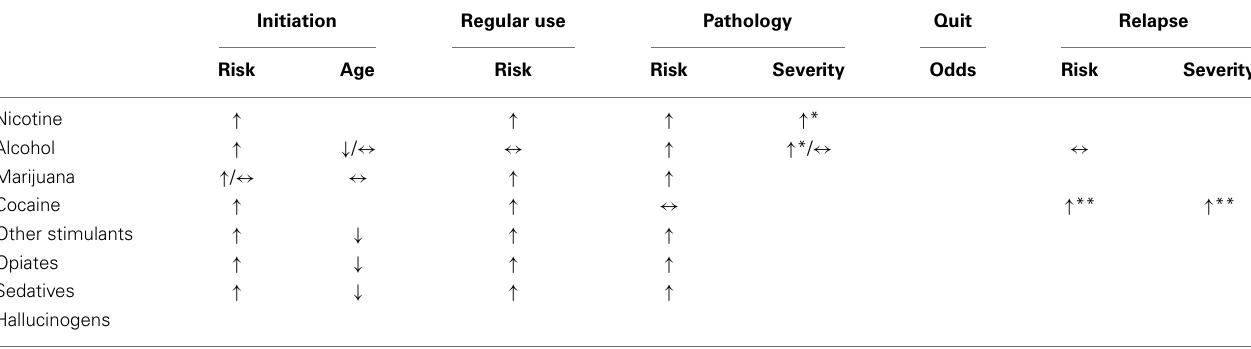
FIGURE 4 | Model of how stressors, in conjunction with chronic or repeated substance use, may affect progression from regular use to abuse or dependence . Repeated activation of stress or motivational systems by stress and substances of abuse can (right side of figure) (1) intensify sensitization of motivational systems and enhance reactivity to and attentional bias for drug-related information; (2) increase HPA axis activation during acute withdrawal instead of